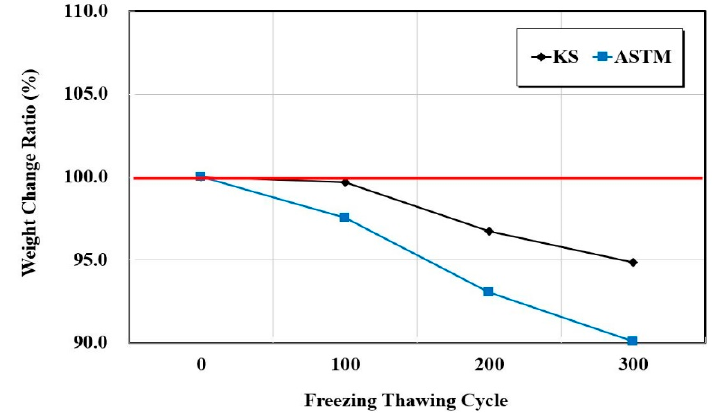
Figure 6. Weight change ratio test results as a function of the freezing–thawing cycle.